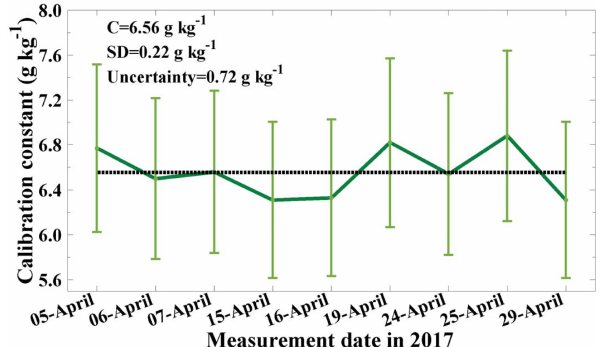
Figure 7. Calibration constants ( C ) determined for nine pairs of lidar and sun photometer observations by using Eq. (8) in the nine selected measurements (thick, green solid line). The error bar shows the overall retrieval error (see Appendix B, Eq. B3). The dotted line shows the mean value of all the nine daily values.